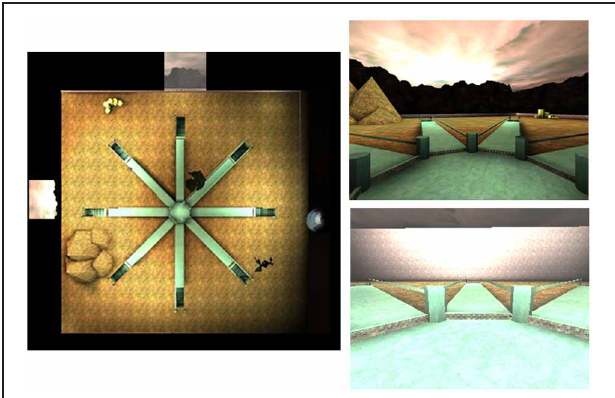
FIGURE 2 | Top down (left) and first person (right) views of the children 4/8VM